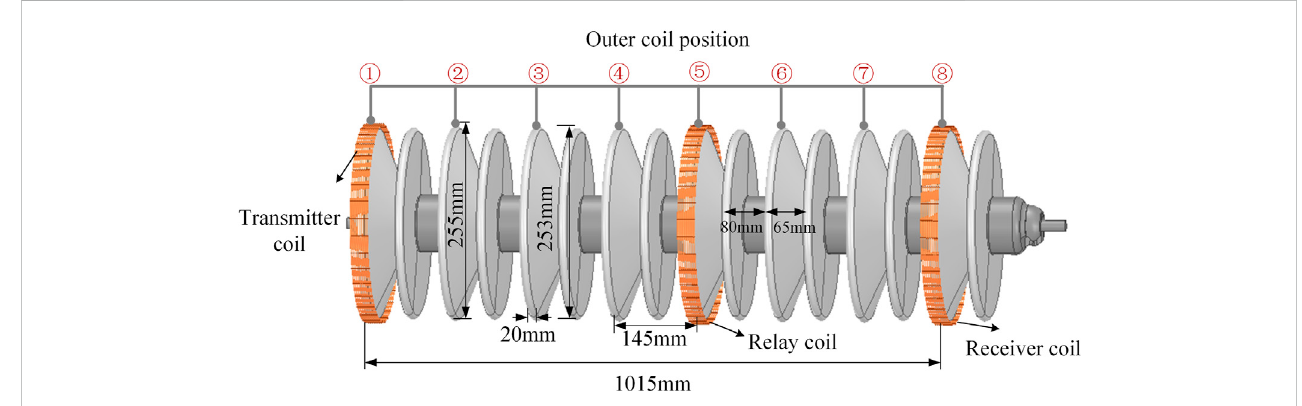
FIGURE 2 110 kV composite insulator embedded coil location diagram.